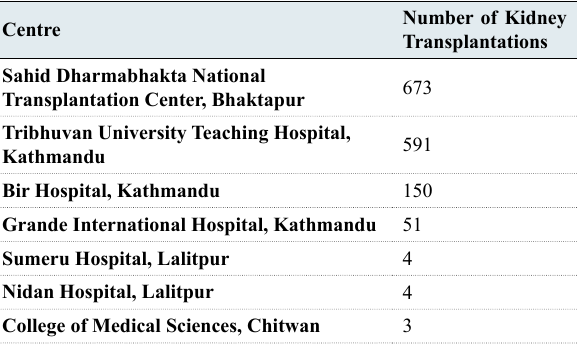
Table 1: Number of kidney transplantations done in various centers of Nepal from August 2008 to October, 2019 Centre